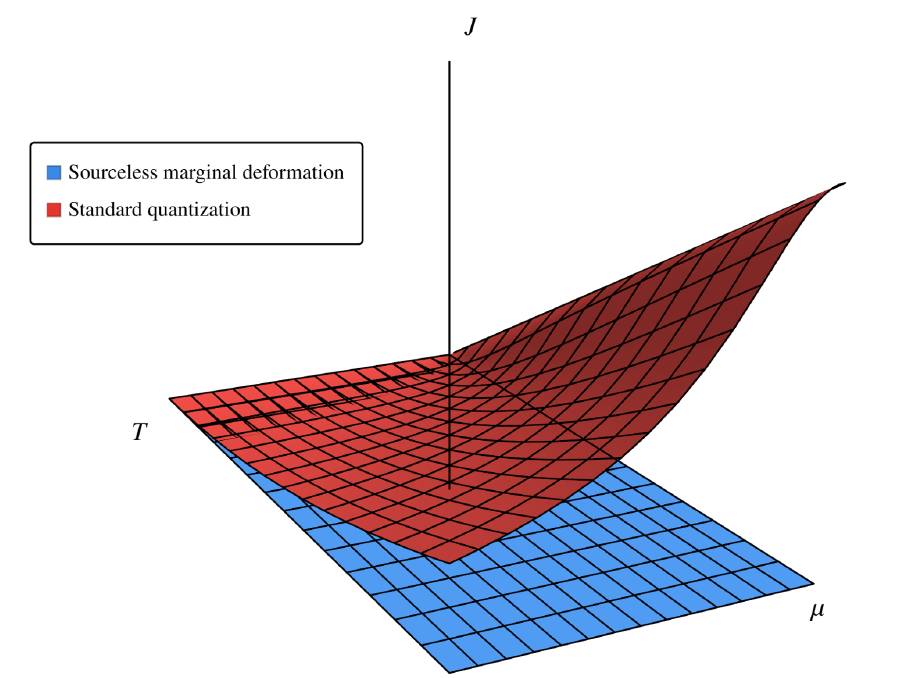
Figure 1 . aGR solution manifold in the thermodynamic parameter space of source { T, µ, J } for two specific choices of boundary interpretations (cases (i) and (ii)). The sourceless marginal case has trivial source and is by itself a 2-charge submanifold while the standard quantization case has a constrained source which leads to the non-trivial corrections in s 1 , ρ 1